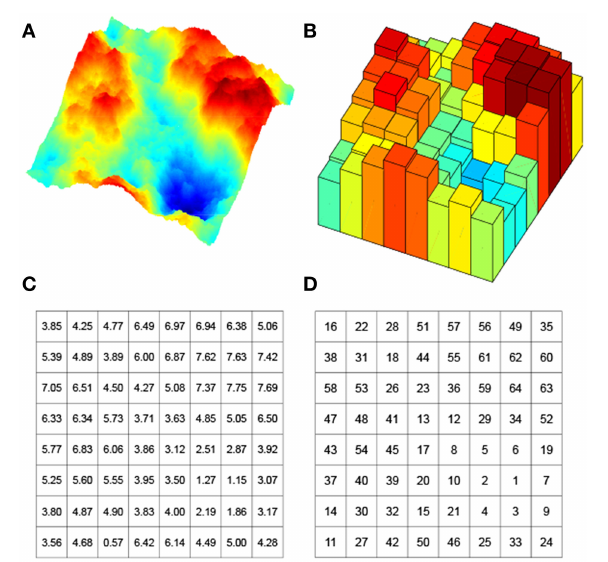
FIGURE 2 | The process of generating a ranked surface. The landscape in (A) is coarse-grained to the low-resolution system of 8 × 8 cells shown in (B) , and then represented as a discretized map of local heights, as depicted in (C) . By ranking these heights in crescent order, one obtains the ranked surface in (D) . In fact, the landscape shown in (A) is a high resolution synthetic map obtained from a fractional Brownian motion simulation based on the Fourier filtering method (see Section